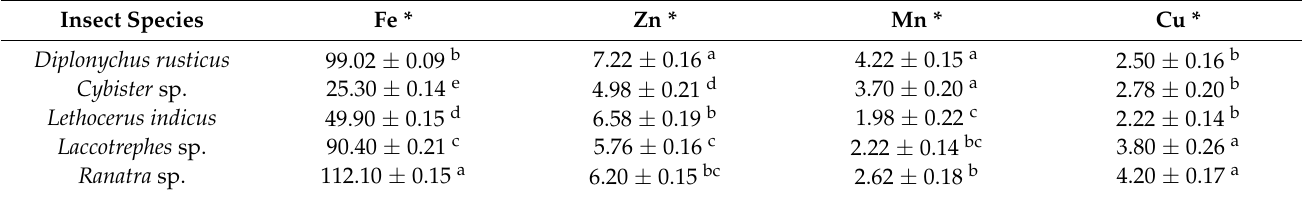
Table 3. Composition of microelements of five aquatic insect species (mg/100 g, d.w.) 1 .